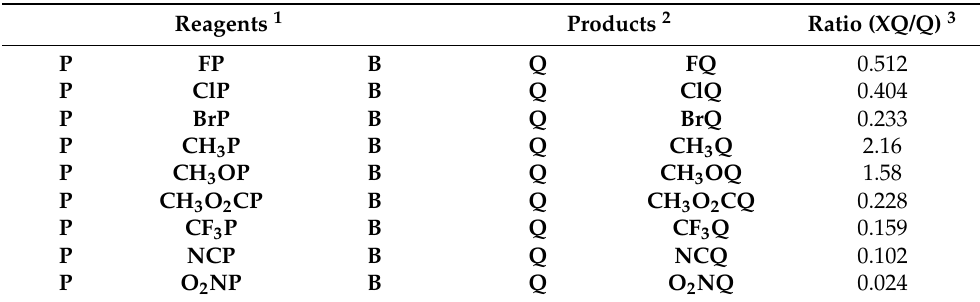
Table 1. Ratio of 2,3-diphenylquinoxaline and 6-substituted-2,3-diphenylquinoxaline formed in competition experiments in the nebulizer.